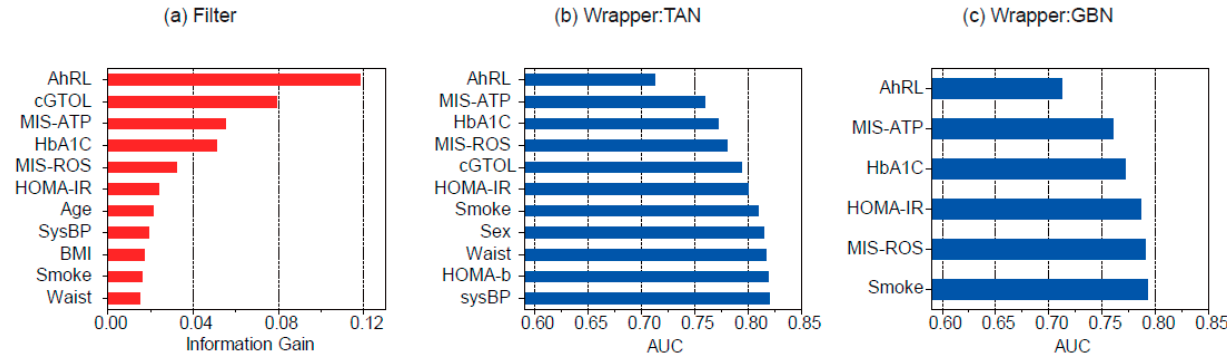
Figure 2. Feature selection results from ( a ) filter method, ( b ) wrapper for TAN, and ( c ) wrapper for GBN.